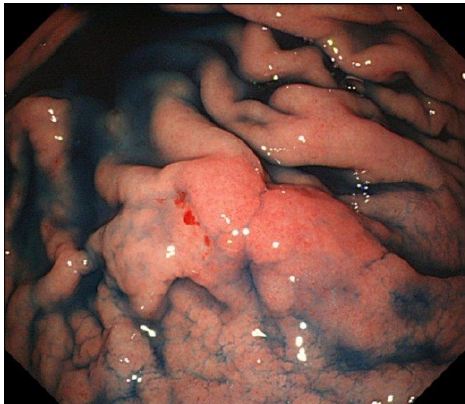
Figure 2. Endoscopic image of an Epstein-Barr virus-associated gastric carcinoma in the upper gastric body. The tumor shows a protruded shape probably because of the abundant lymphocyte